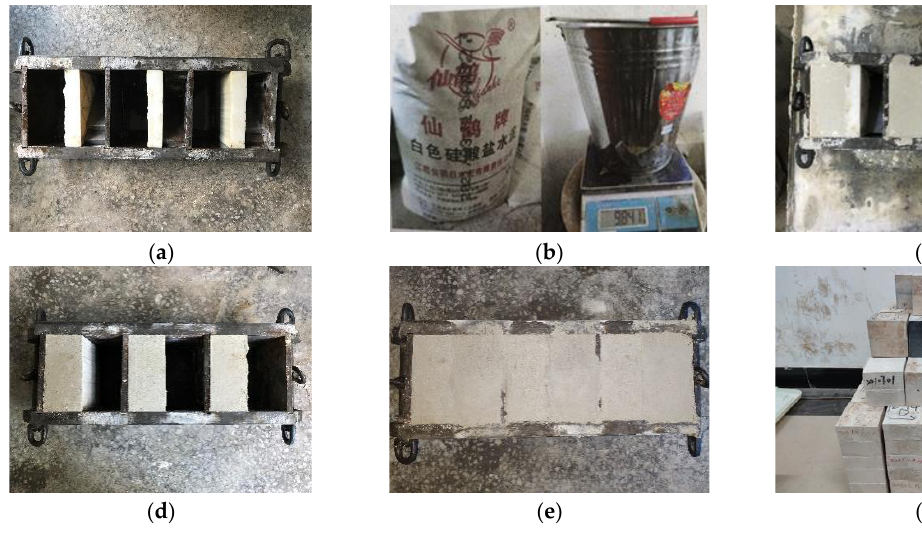
Figure 3. The production process of the specimen. ( a ) Installation of mold. ( b ) Weighing of raw material. ( c ) Casting and vibration. ( d ) Pouring of the bottom half of the specimen. ( e ) Complete specimen. ( f ) Cured specimen. Table 1. Mechanical parameters of joint.